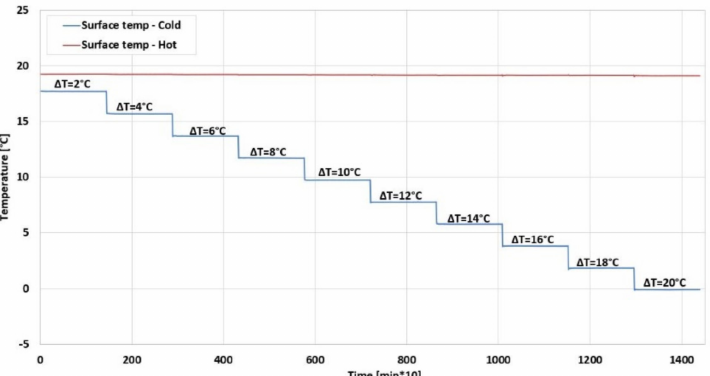
Figure 2. Temperature trends within the GHB for the different cases considered (the acquired data were processed within a graph showing only the last 24 h of measurement for each temper- ature